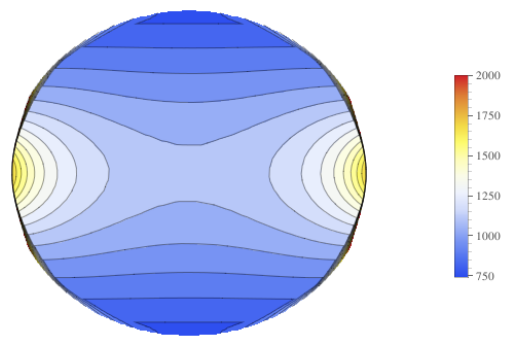
Figure 9. Contour plot of the mean for the electrical field experienced by the Tumor.